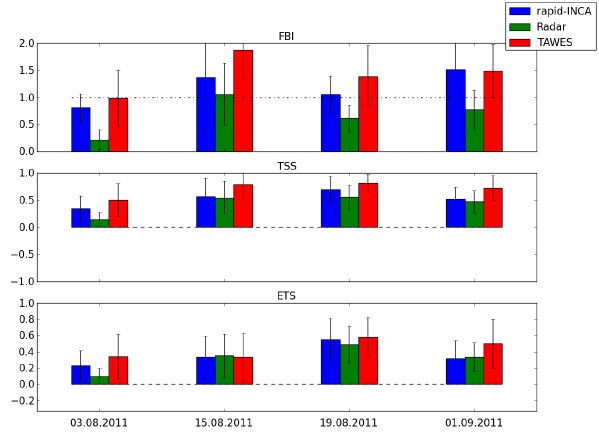
Figure 10. Skill scores for threshold of 0.5mm/5min. Scores are computed at each WegenerNet station and then averaged over space. Error bars indicate the standard deviation of the scores.